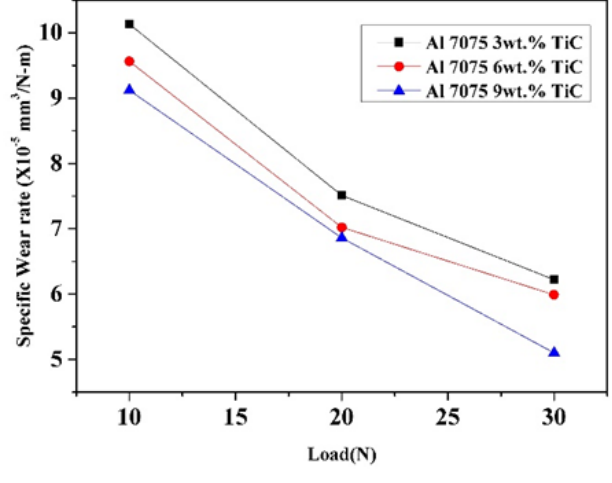
Fig. 12. Variation of wear rate with